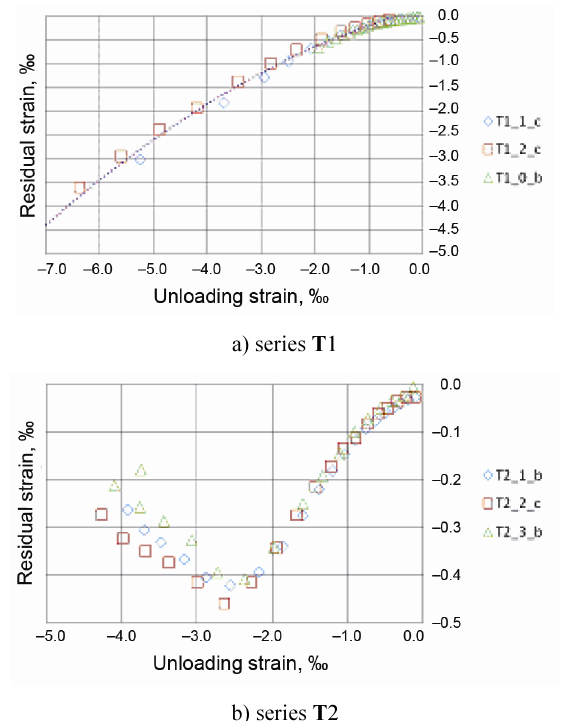
Fig. 19. Residual strain and envelope unloading